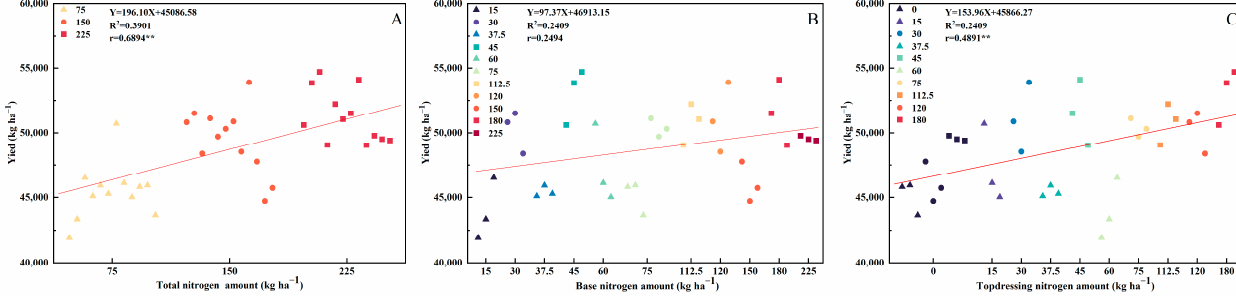
Figure 6. Fitting analysis of different nitrogen application rates and yields, total N amount ( A ), base N amount ( B ), topdressing N amount ( C ). R 2 —linear correlation coefficient, r—Spearman rank correlation coefficient, ** p < 0.01.